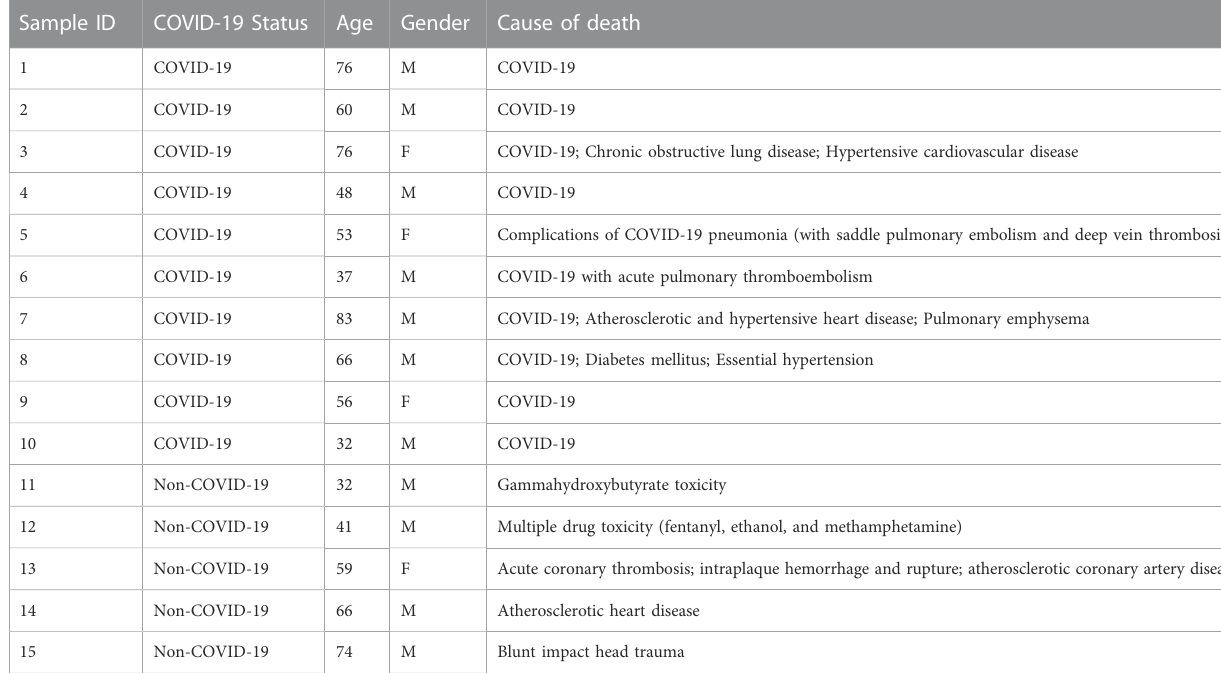
TABLE 1 Clinical and demographic characteristics for patients included in the immunohistochemistry study. Sample